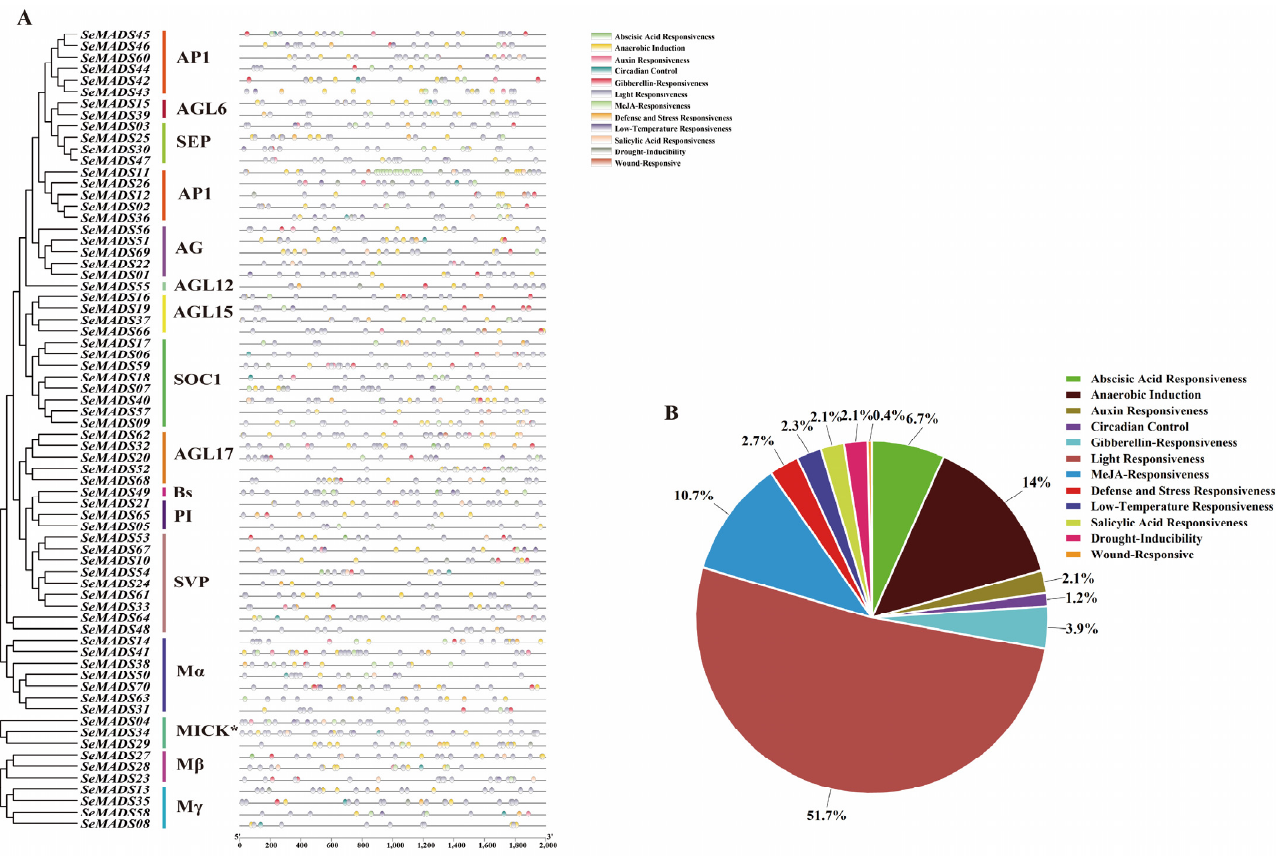
Figure 4. Cis-acting elements analysis of SeMADS-box in S. edule. ( A ) Distribution of cis-acting elements in each member of the SeMADS-box family. ( B ) Pie chart showing the percentage of di ff erent cis-regulatory elements predicted in S e MADS-box genes ʹ promoter sequences.